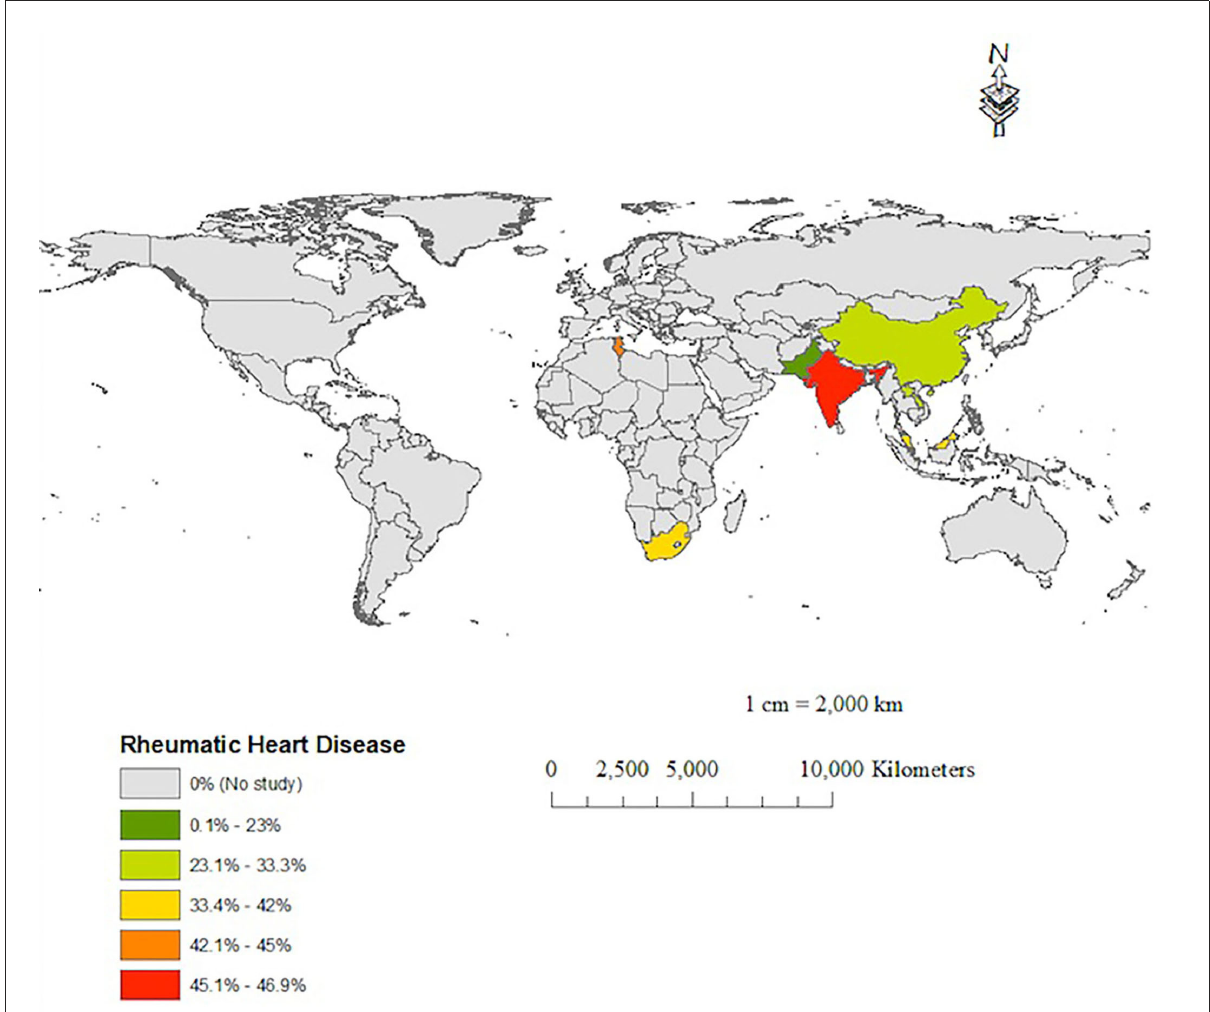
FIGURE2 A map showing the prevalence of rheumatic heart disease as a predisposing condition of IE in the reported IE